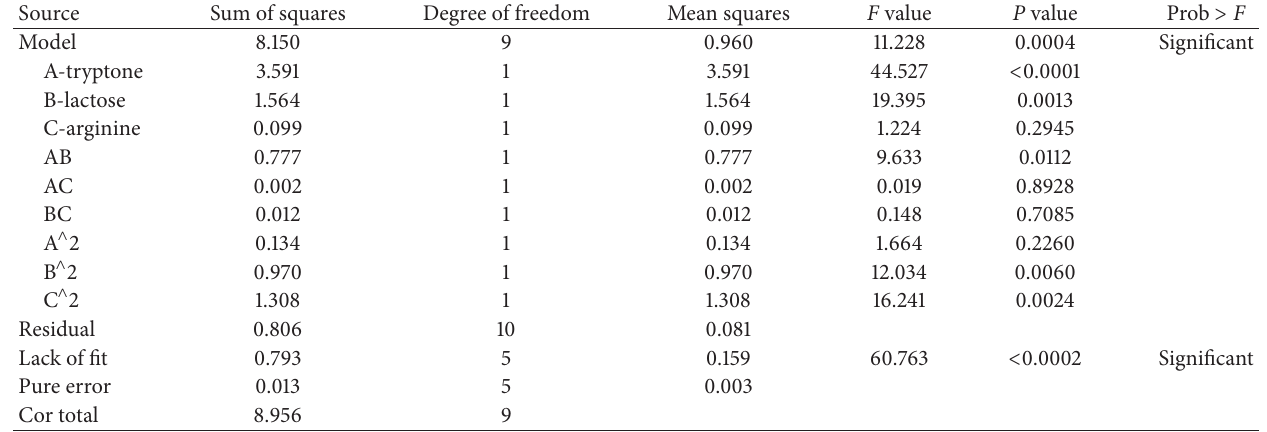
Table 5: Regression analysis (ANOVA) for the growth.